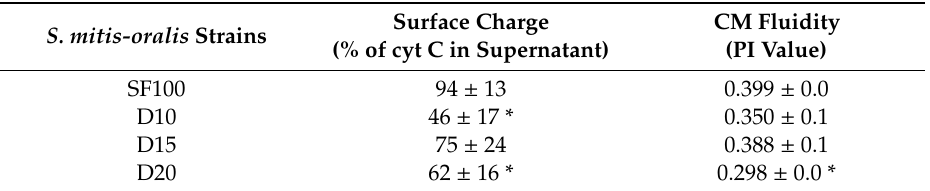
Table 3. Positive surface charge and cell membrane (CM) fluidity of S. mitis-oralis SF100 and its DAP-R variants at days 10, 15, and 20 post-in vitro DAP passage.